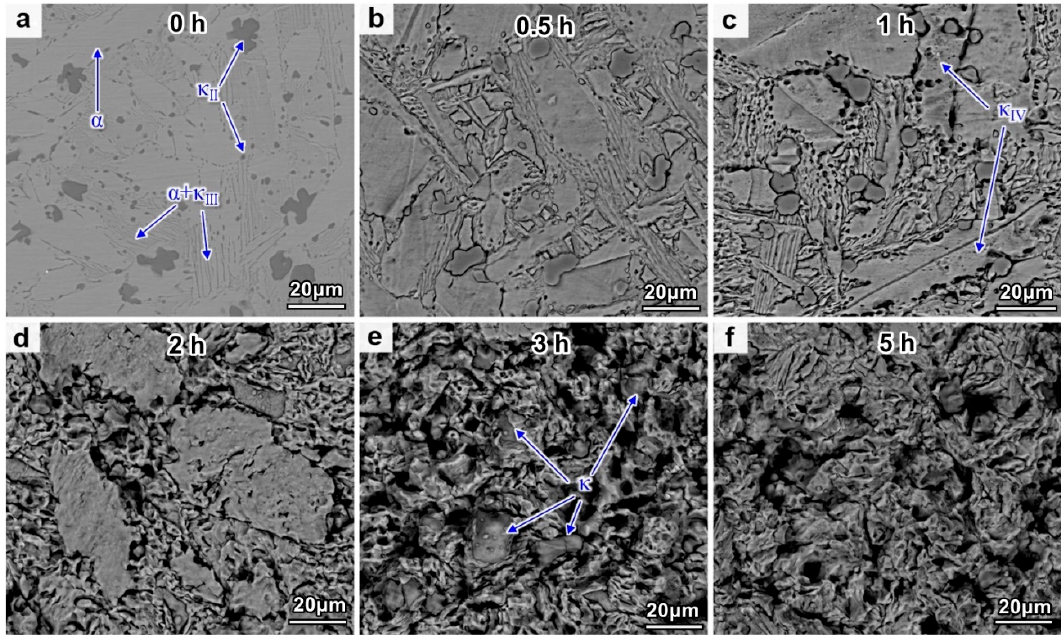
Figure 3. Surface morphologies of NAB after different CE times: ( a ) 0 h; ( b ) 0.5 h; ( c ) 1 h; ( d ) 2 h; ( e ) 3 h; ( f ) 5 h.